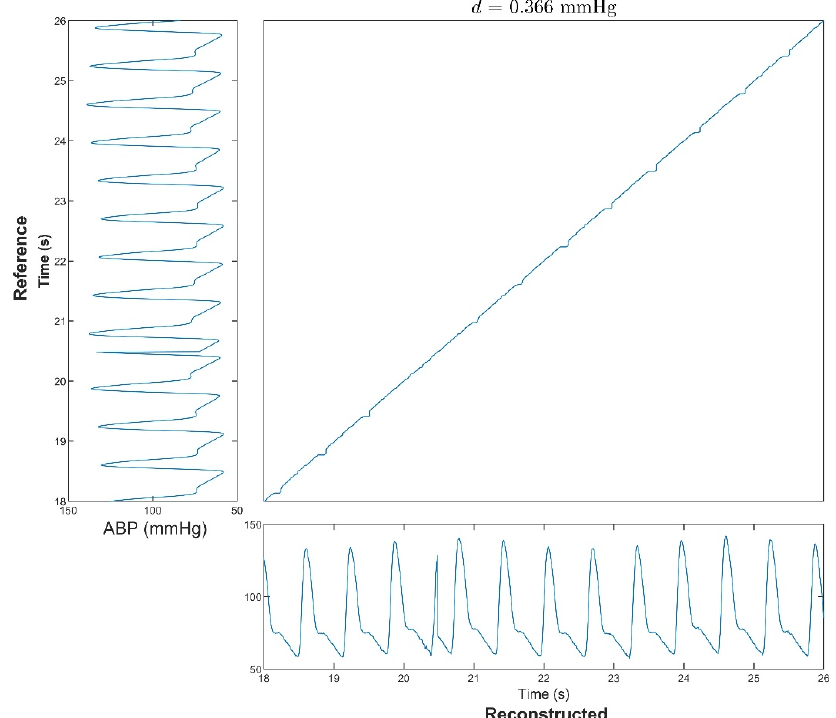
Figure 6. A segment of the optimal DTW warping path for the reference and reconstructed ABPs. The d stands for the normalized DTW distance. This figure shows that the reconstructed ABP was highly similar to the reference ABP. Note that ABP = Arterial blood pressure and DTW = Dynamic time